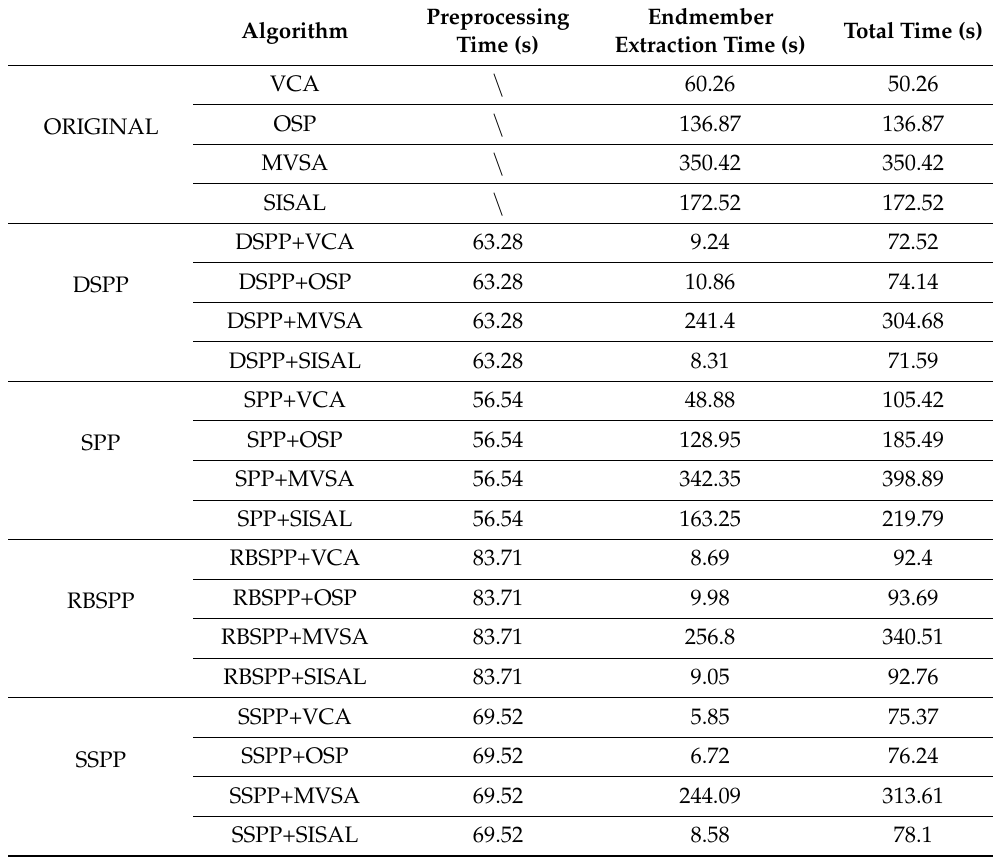
Table 3. Processing time comparisons using different